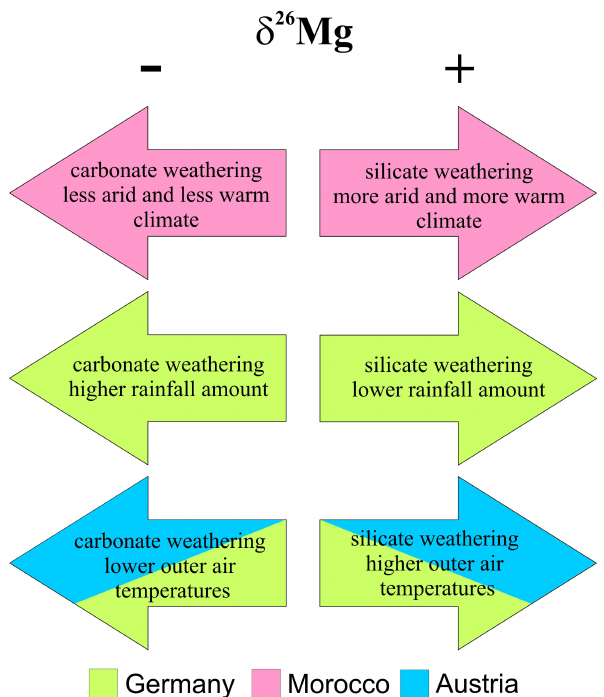
Fig. 12. Conceptual model summarising factors affecting Mg- isotope ratios of speleothems from four different climate